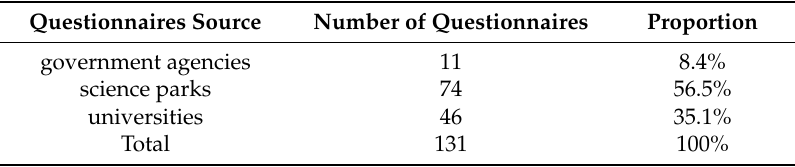
Table 5. Number of questionnaires by respondent source.